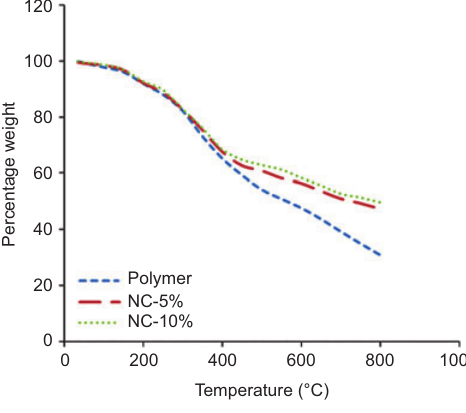
Figure 5 TGA thermograms of neat PA 3 and PA-nanocomposite fi lms 3a and 3b